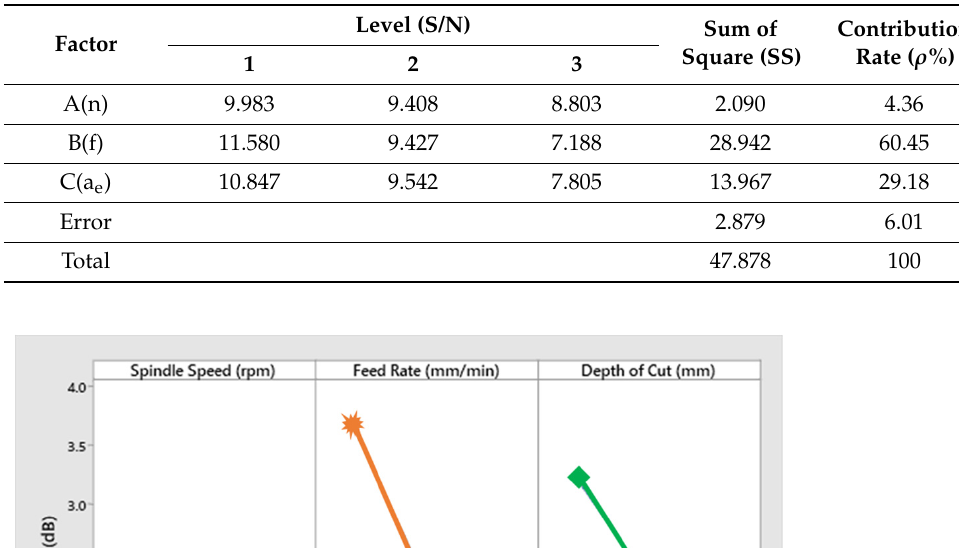
Table 6. Hybrid-assisted milling (Si 3 N 4 ) surface roughness variance analysis.